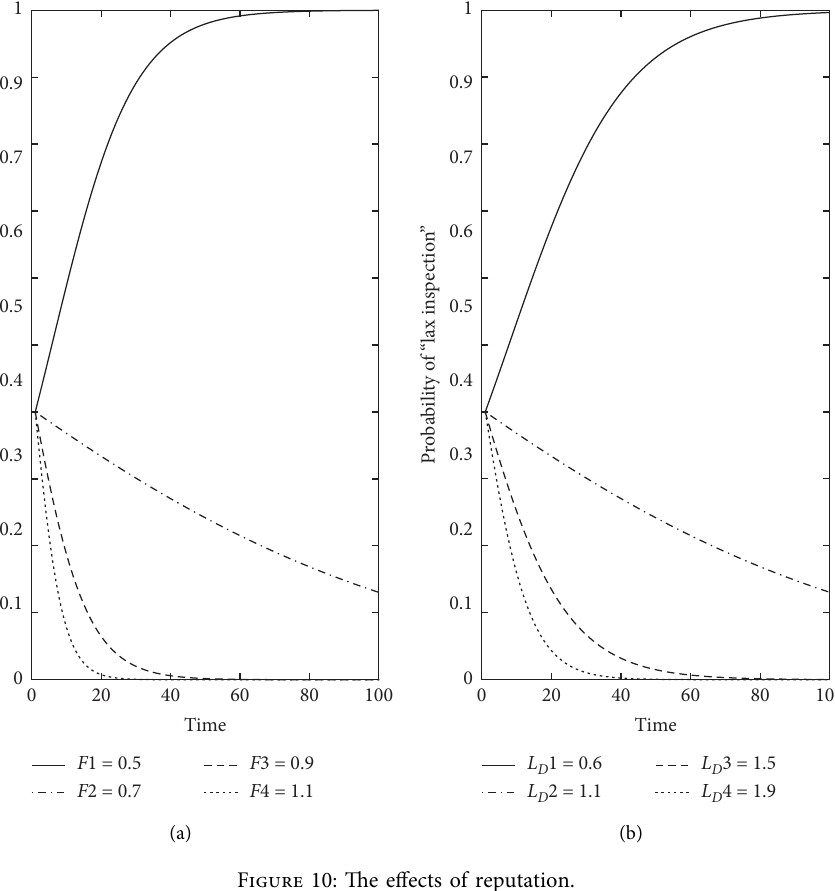
Figure 10: The effects of reputation.